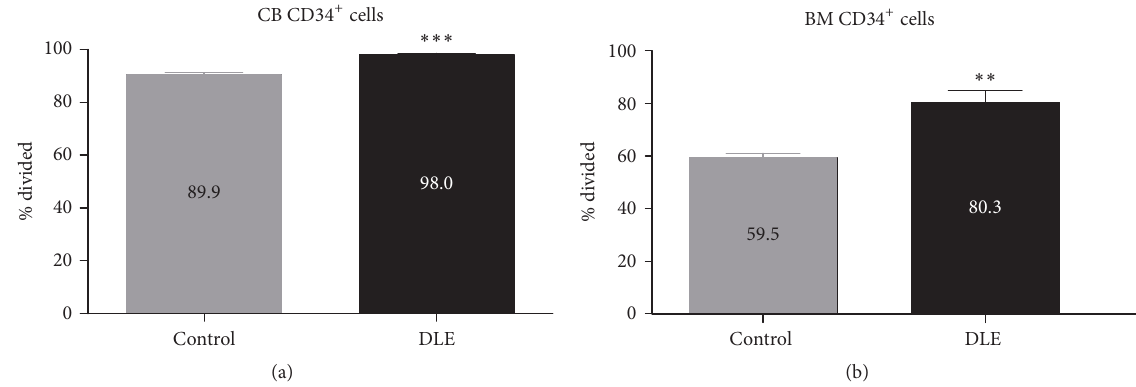
Figure 1: Dialyzable leukocyte extracts (DLE) promote proliferation of primitive hematopoietic CD34 + cells from neonatal and adult sources. CD34 + cells from adult bone marrow (ABM) and umbilical cord blood (UCB) were enriched and cultured for 72 hours with DLE Transferon and BrdU. Cells were stained for the identification of CD34 + cell progenitors followed by intracellular staining of BrdU. Multiparametric flow cytometry was performed in a FACSCanto II and the cell frequencies of BrdU + cells calculated. Data are representative of 3 independent experiments. ∗ 𝑃 < 0.05 ; ∗∗ 𝑃 < 0.01